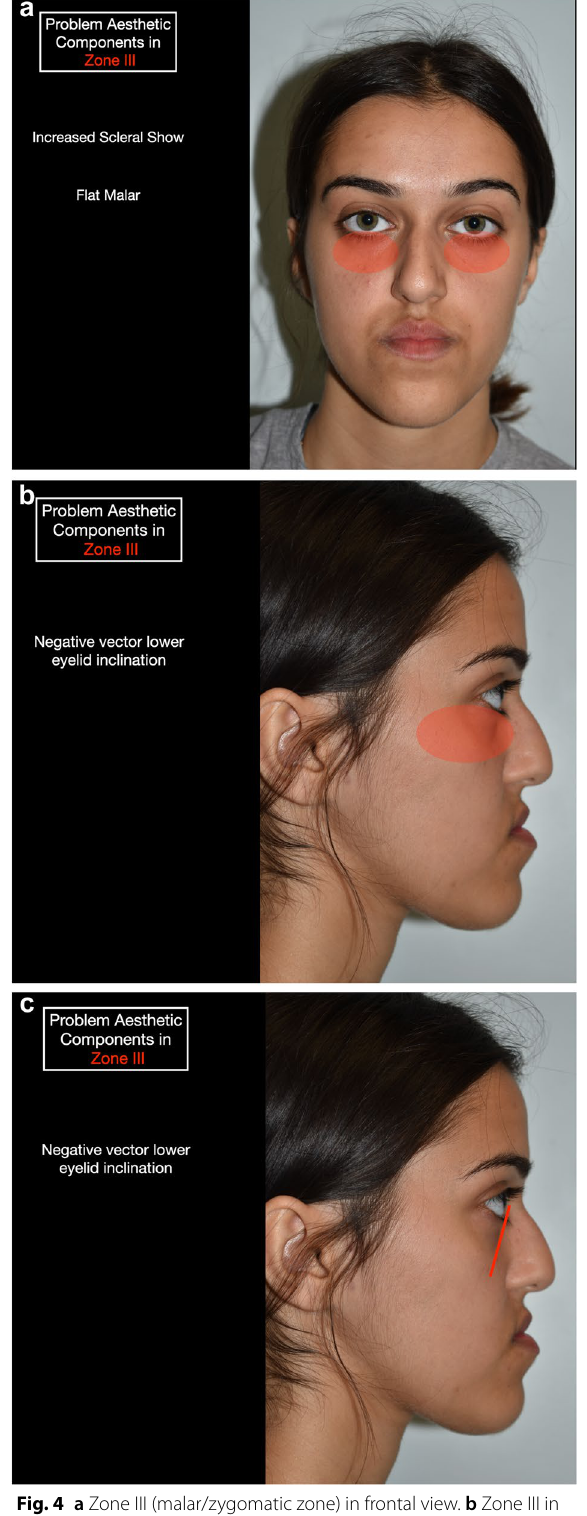
Fig. 4 a Zone III (malar/zygomatic zone) in frontal view. b Zone III in profile view. c Negative vector of the lower eyelid evident in profile view in zone III